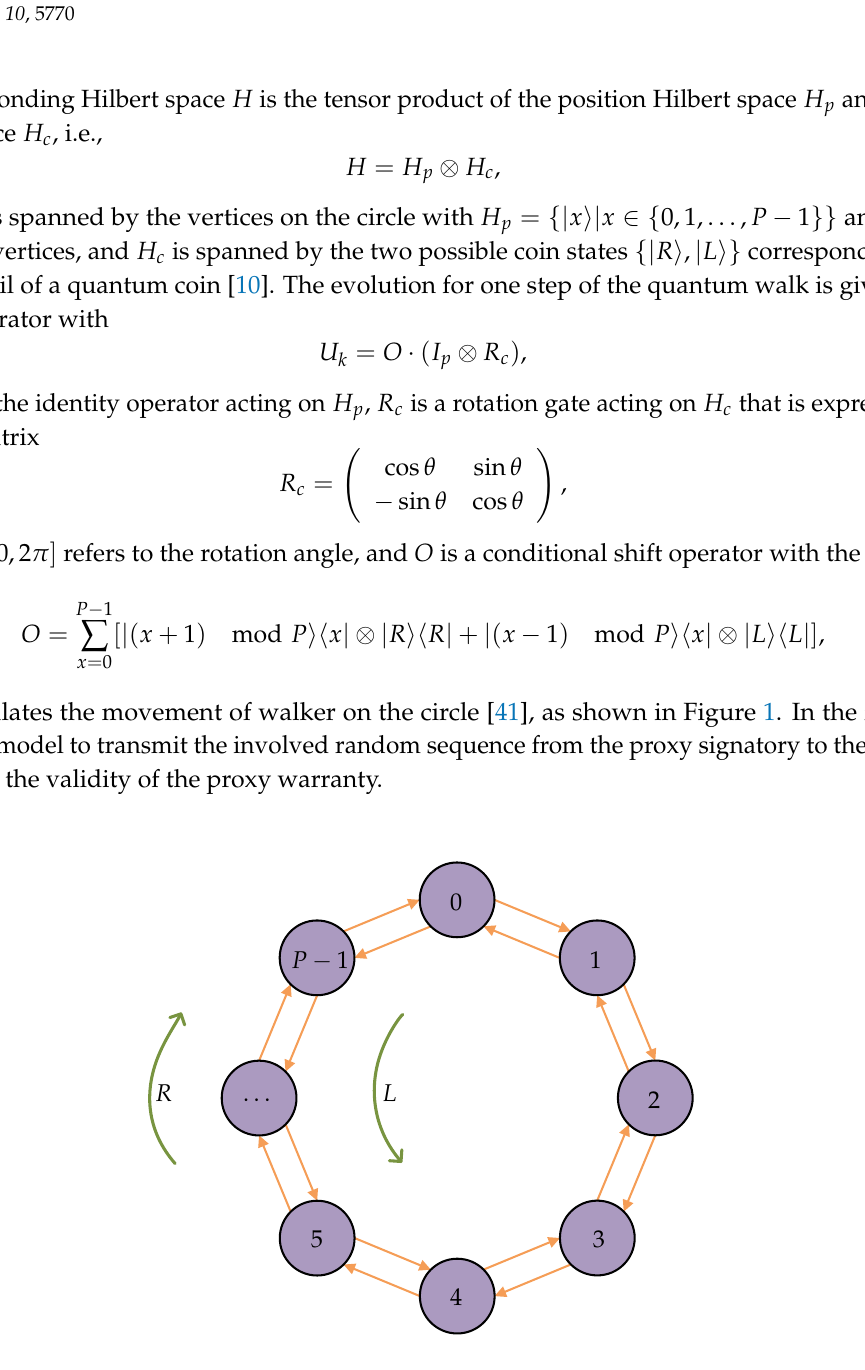
Figure 1. Shift rules of quantum walks on a circle with P Figure 6. Quantum Walks